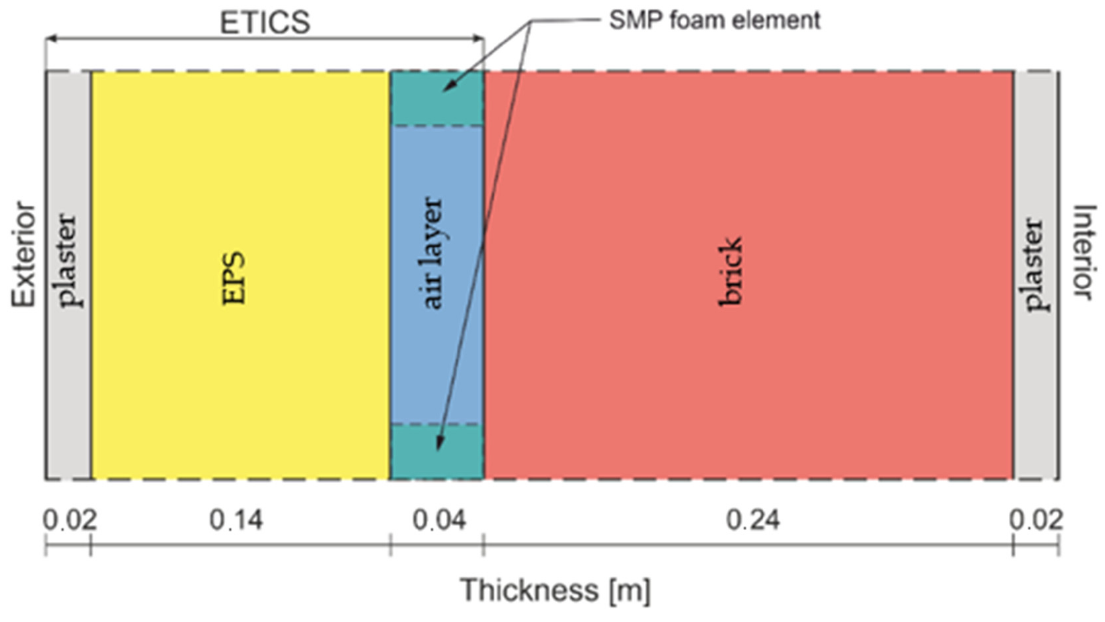
Figure 1. One ‐ dimensional cross ‐ section of the defined wall construction with the ETICS and the Figure 1. One-dimensional cross-section of the defined wall construction with the ETICS and the ventilation space behind, as well as the foam elements. ventilation space behind, as well as the foam